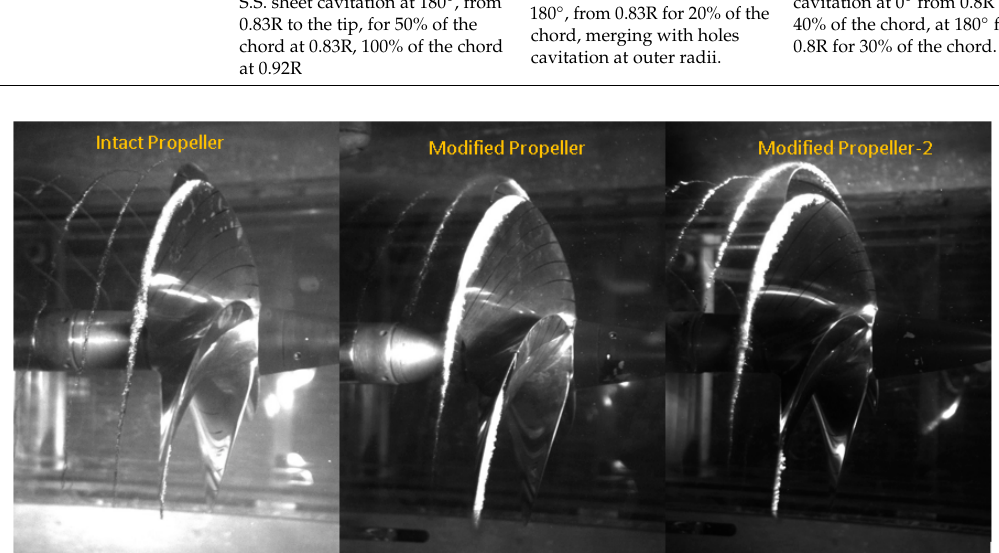
Figure 13. Intact vs. Modified propeller and Modified Propeller-2 in condition V1 and viewed from starboard.